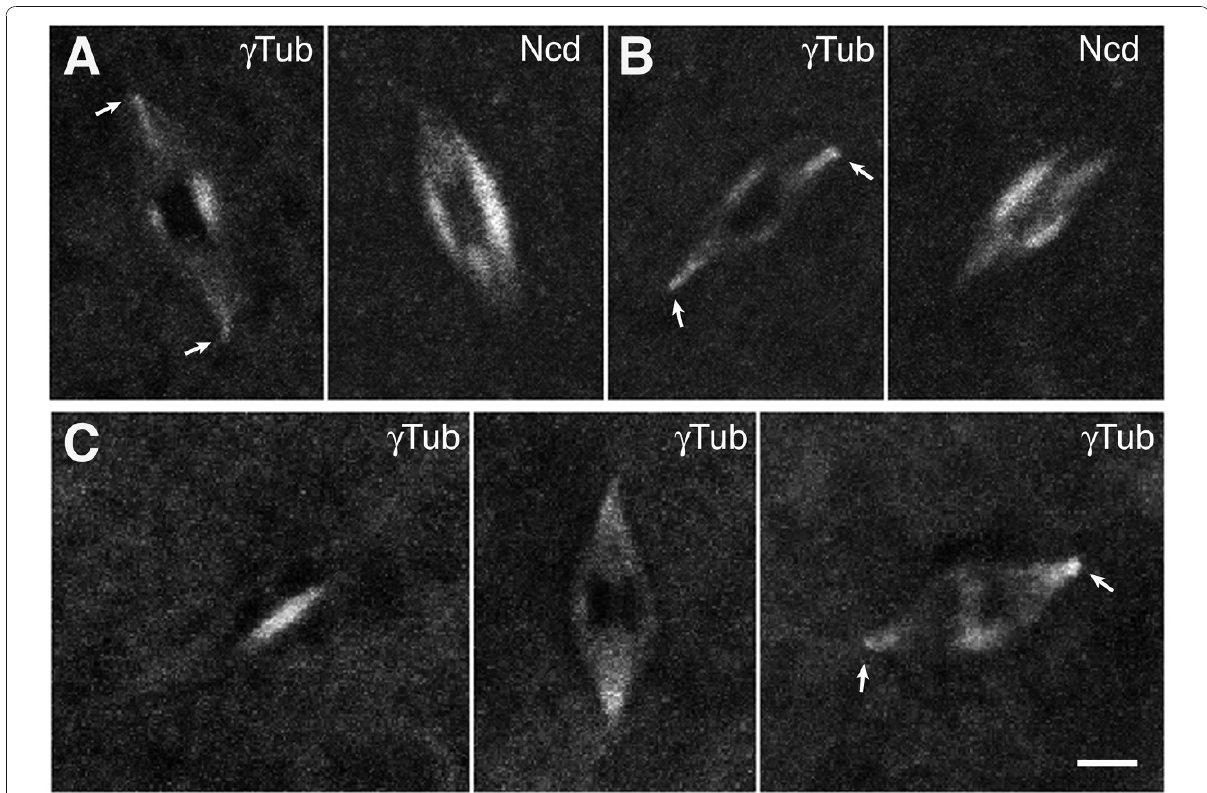
Figure 1 g -Tubulin localizes to oocyte MI spindles . (A) MI spindle of a late stage 13 or (B) stage 14 oocyte expressing g Tub37C-GFP ( g Tub, left) and Ncd-mRFP1 (Ncd, right). (C) MI spindles of a late stage 13 oocyte (left) or stage 14 oocytes (middle, right) expressing g Tub37C-GFP but not Ncd-mRFP1. g -Tubulin is present in the MI spindle midzone and at the spindle poles, including pole bodies (arrows). Bar, 3 μ m.